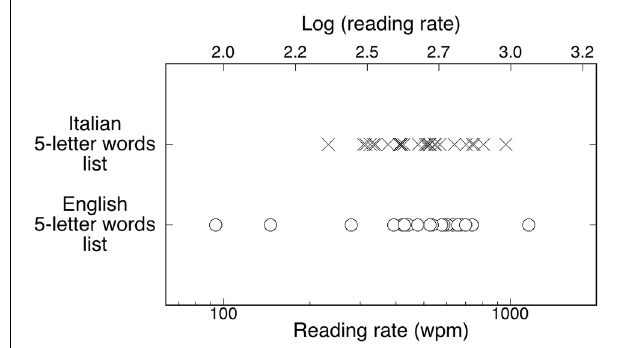
FIGURE 1 | Individual reading rates for Italian readers (Xs) and English participants (open circles) for a letter-matched list of words. The upper scale shows the corresponding values expressed as a log (wpm). Note the greater dispersion of experimental points among English than Italian